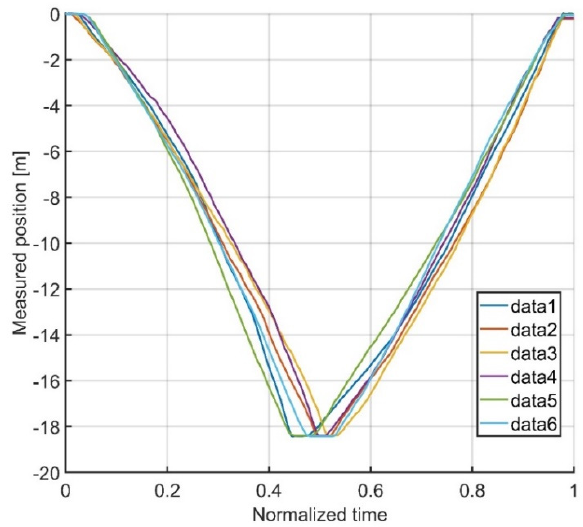
Figure 9. GPR position retrieved by interferometric radar.